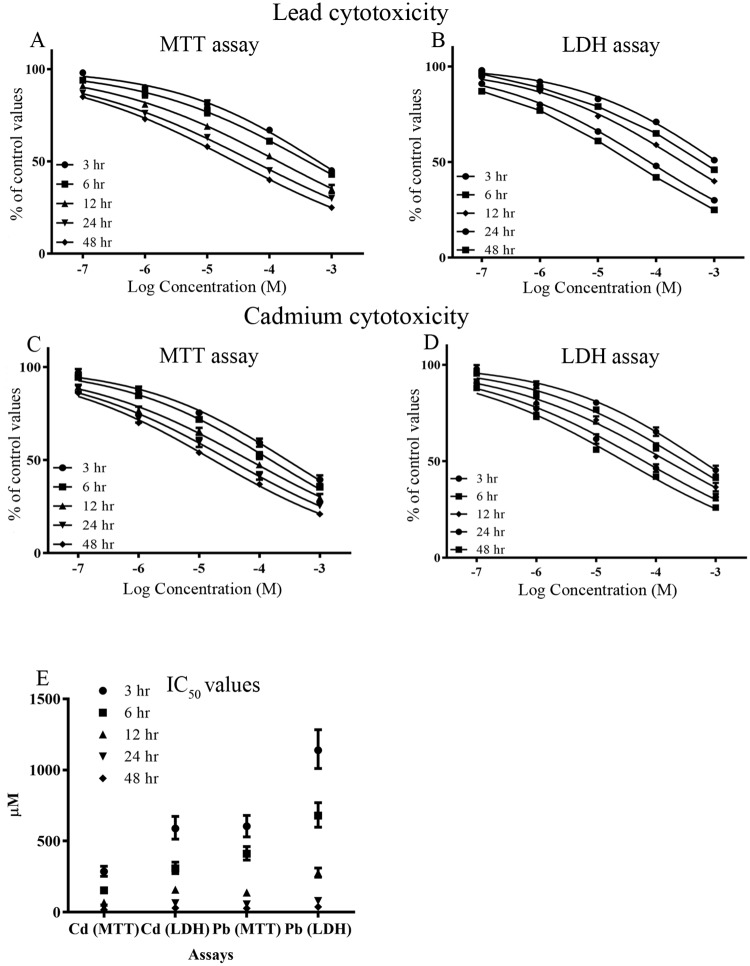
Lead and cadmium cytotoxicity to human osteoblasts in vitro.Human osteoblasts were treated with lead or cadmium over a concentration range of 0.1–1000 μM and for 3–48 hours and the level of cell metabolic activity and viability determined by MTT and LDH assays (A-D). The concentrations of lead or cadmium that produced 50% inhibition of metabolic activity or cell viability were determined (E). Data points are representative of 9 independent experiments.